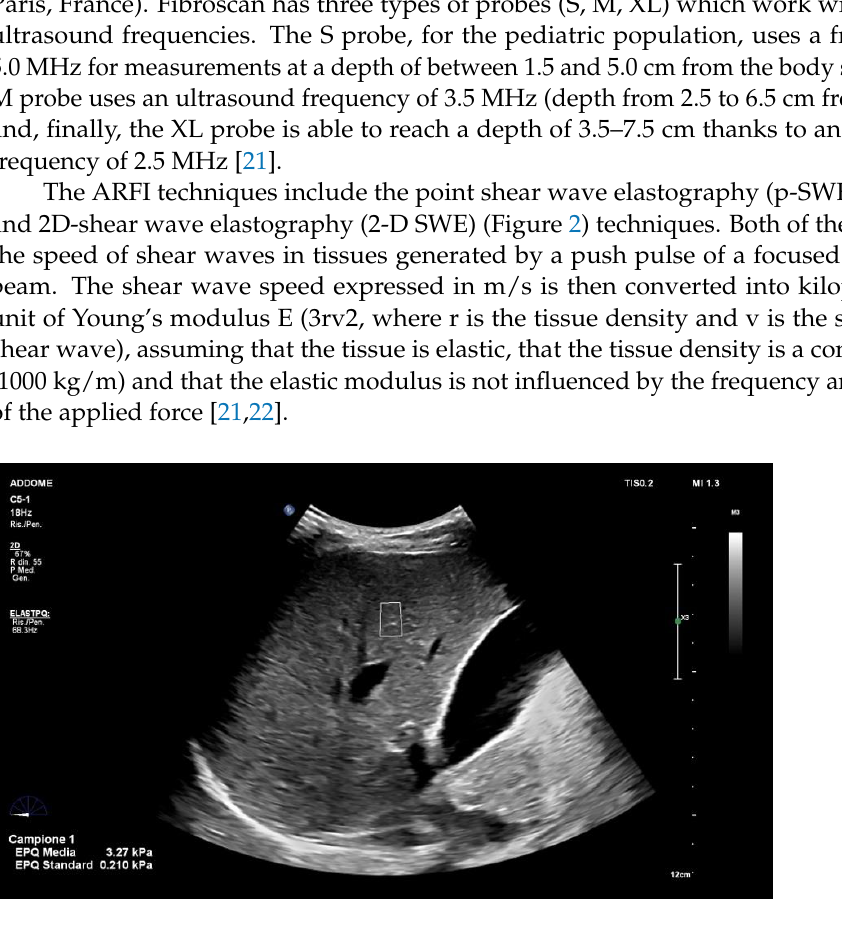
Figure 1. Point shear wave elastography (ElastPQ; Philips Medical System, Best, the Netherlands). The shear wave velocity is measured in the region of interest (ROI) marked by the white line, which can be moved on the screen. Measurements may be expressed as m/s or KPa. Ten measurements should be obtained from 10 independent images, in the same location. The final result should be expressed as the median together with the IQR/M. IQR/M should be ≤ 30% of the 10 measurements expressed as kilopascals and ≤ 15% for measurements expressed as meters per second. Measurement should be taken at least 15 – 20 mm below liver capsule [23].